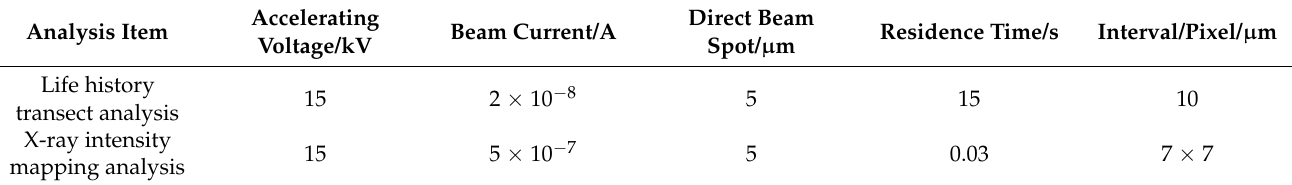
Table 1. The parameter values of EMPA analysis.